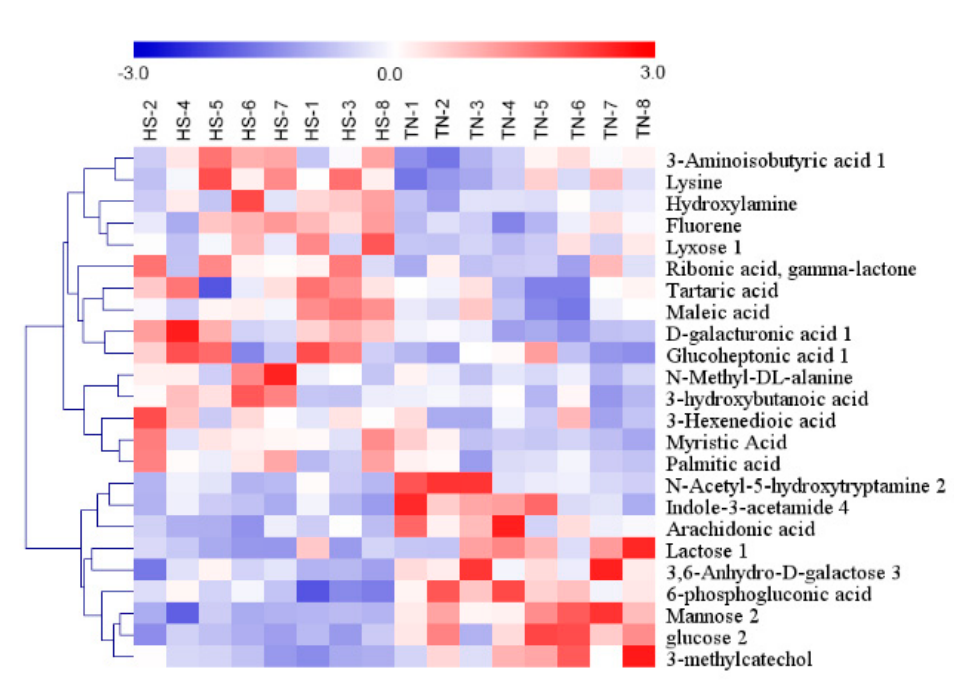
Figure 4. Hierarchical cluster analysis of twenty-four metabolites with significantly different levels in serum of finishing pigs. Red indicates high relative abundance, and blue indicates low relative abundance.